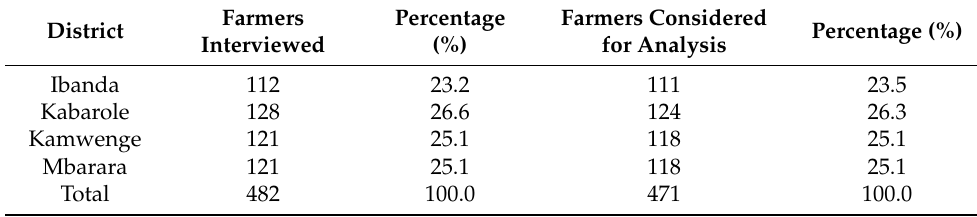
Table 1. Farmer distribution in the sampled